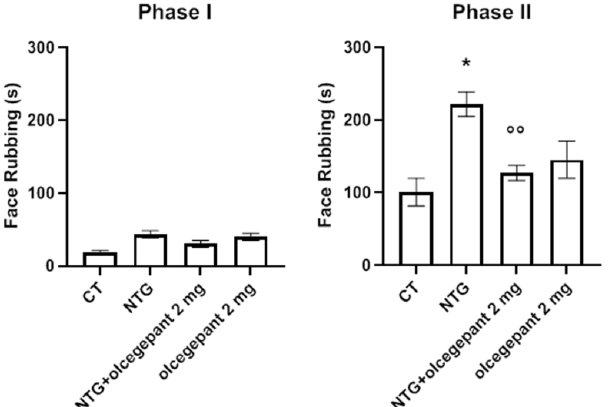
Figure 3. Time of face rubbing (expressed in seconds) during Phase I and II of the orofacial formalin formalin test following chronic systemic administration of nitroglycerin (NTG)/vehicle and ol- multiple comparisons test: * p < 0.05 vs. control (CT) and olcegepant 2 mg; ◦◦ p < 0.01 vs. NTG.